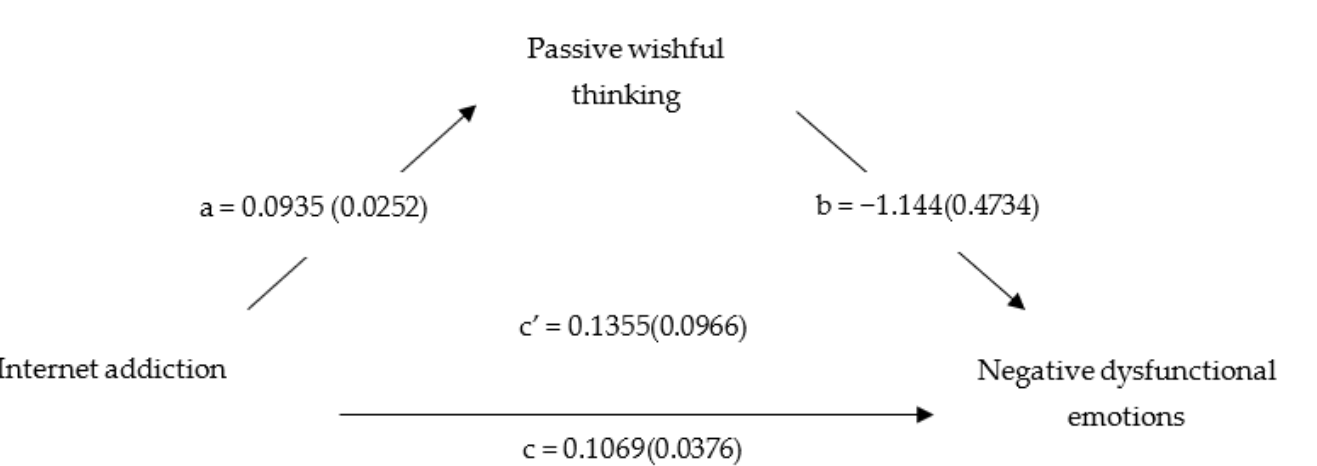
Figure 4. Values are path coefficients representing unstandardized regression weights and standard errors. The paths are represented as follows: a = independent variable to mediator; b = mediator of dependent variable; c = total effects of independent variable on dependent variable; c’ = direct effect of independent variable on dependent variable .